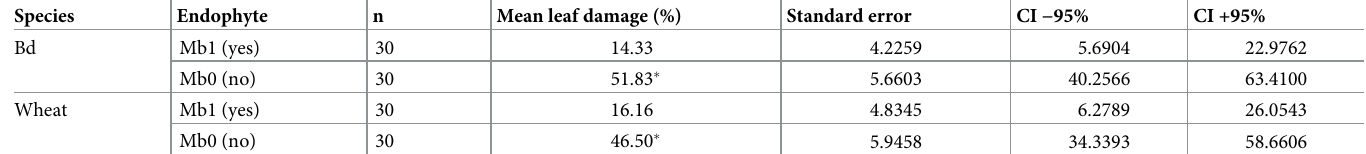
Table 2. Tukey’s post hoc test for each species and treatment examining damage to leaves of B . distachyon and wheat by pathogen F . culmorum . The main experi- mental factor is previous inoculation with the endophytic fungus M . bolleyi . CI– 95% confidence intervals. α = 0.05, statistically significant difference marked with asterisk ( �